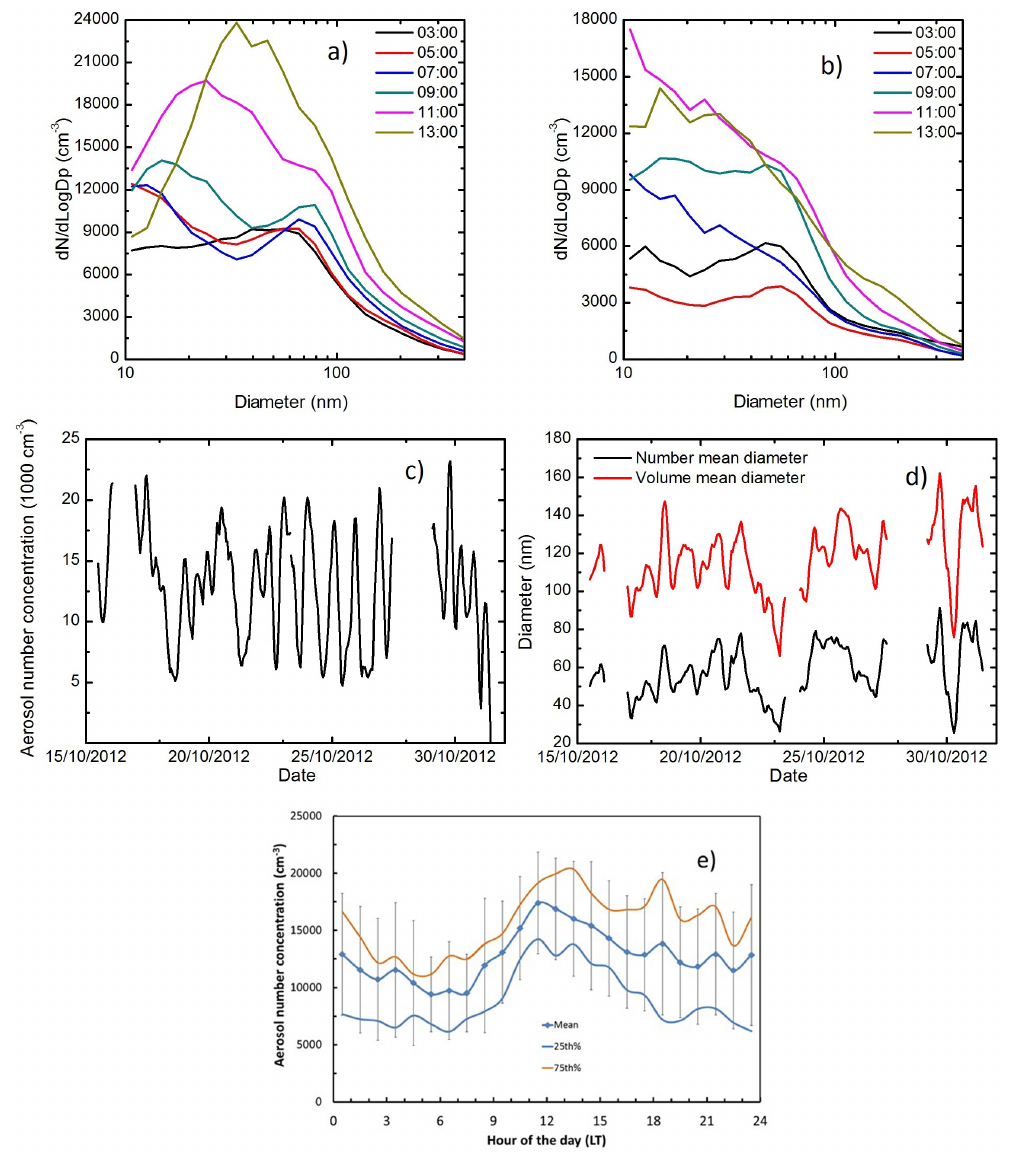
Figure 3. (a) Aerosol size distribution during 16 October 2012 in SP, (b) the same as in (a) , but for 17 October. (c) Total particle concentration from 10 to 500nm, (d) mean particle diameter and mean particle volumetric diameter, and (e) total particle number concentration. The 25 and 75% lines refer to the first and third quartiles while bars represent standard